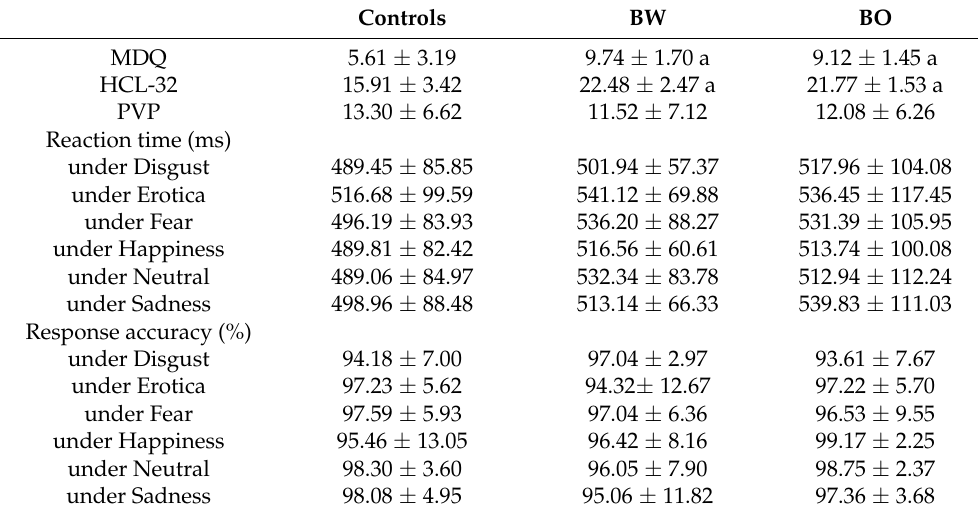
Table 1. Mental health symptoms, reaction times, and response accuracies to target stimuli (mean ± SD) in the healthy volunteers (Controls, n = 54), bipolar I disorder patients with (BW, n = 27) and without (BO, n = 26)